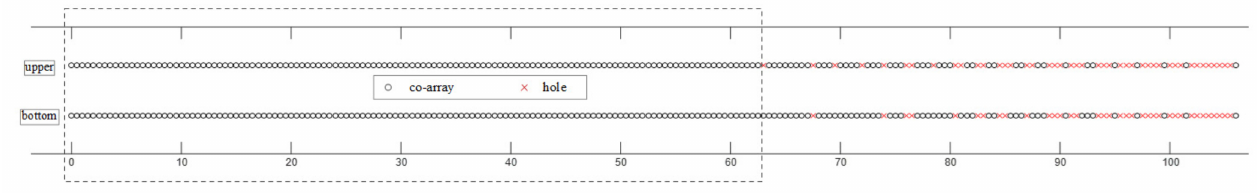
Figure 4. Consecutive DOF